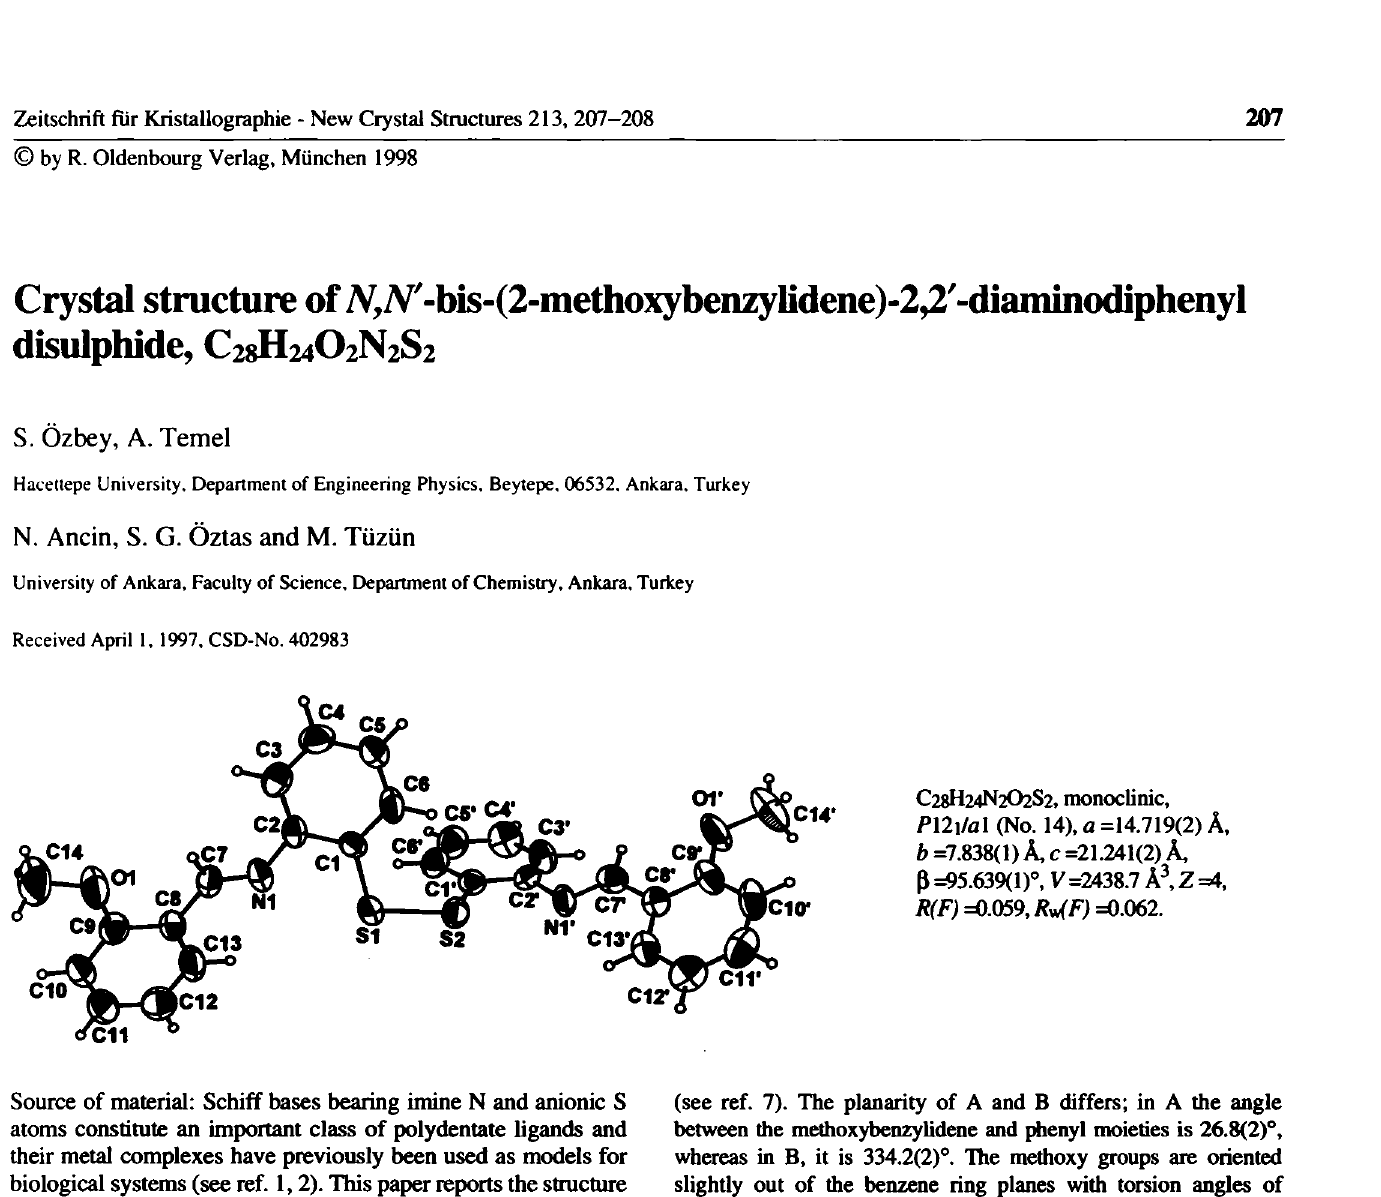
Table 1. Parameters used for the X-ray data collection Crystal: